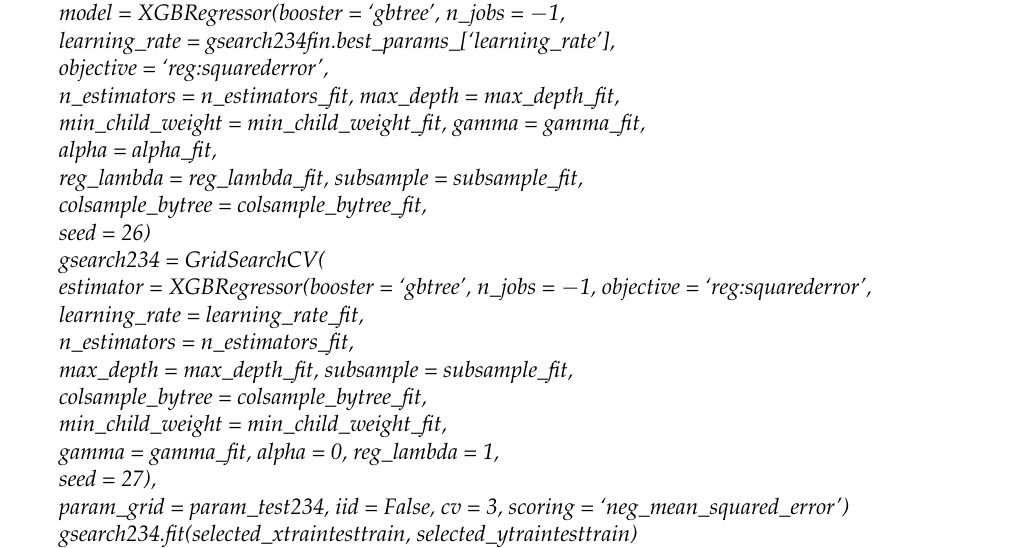
Table A1. XGBoost